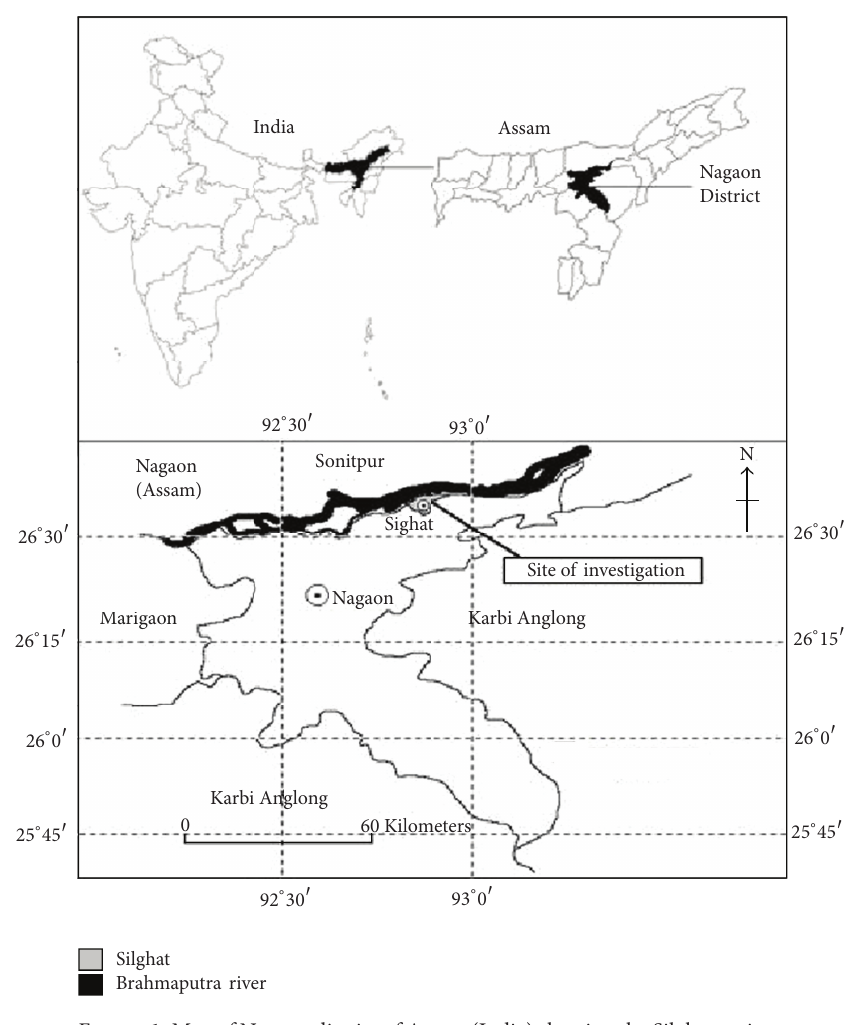
F 1: Map of Nagaon district of Assam (India) showing the Silghat region.